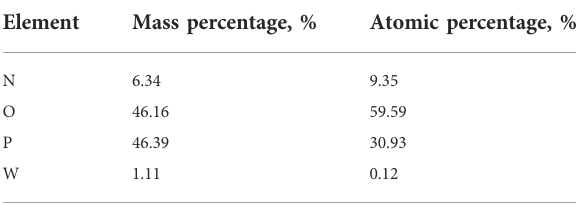
TABLE2Elementscontentanalysisofmicrozone1oftheprecipitated crystals (shown in Figure